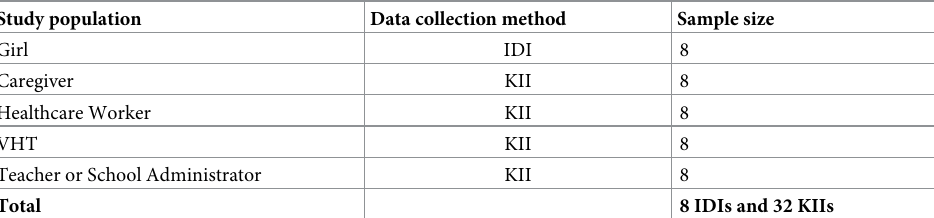
Table 1. Study population, type and number of